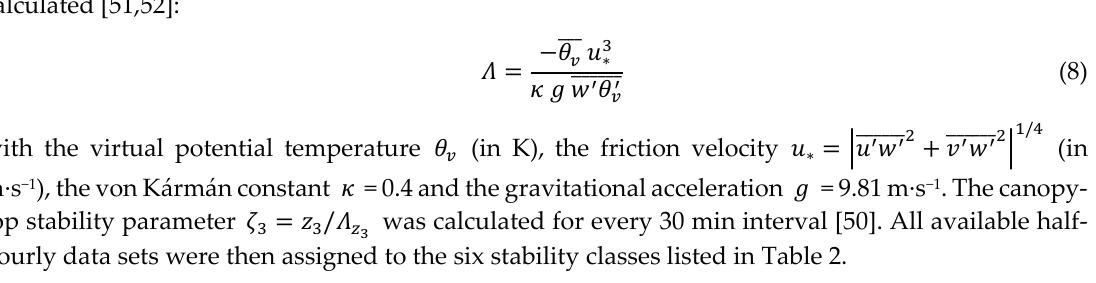
Table 2. Classification of atmospheric stability according to the stability parameter (cid:2014) (cid:2871) . Stability